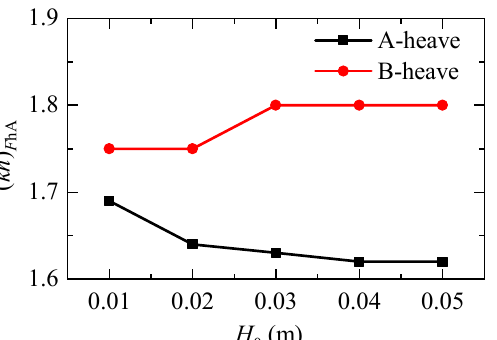
Figure 6. Variations of the dimensionless wavenumber ( kh ) Fh A with respect to the incident wave height for both the A-Heave and B-Heave structure systems.